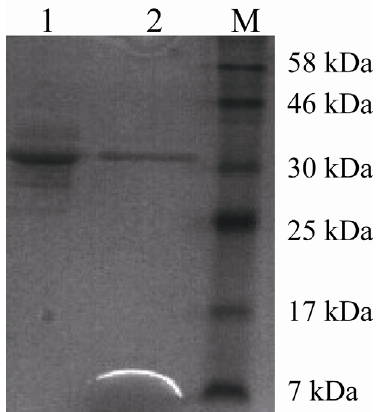
Figure 2. Sodium dodecyl sulfate-polyacrylamide gel electrophoresis (SDS-PAGE) of the expression and purification of rProROL in P. pastoris X-33. Lane M : molecular weight standards; Lane 1 : 11 μ g protein from ultrafiltration; Lane 2 : 7 μ g protein from SP Sepharose FF